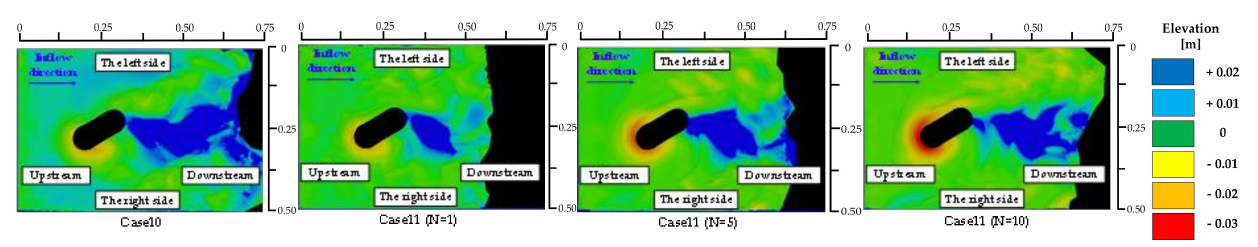
Figure 3. Local scour depth after the experiment for Cases 8 and 9. ( θ = 0 ◦ , H 1 = 0.075 m, T = 600 s).